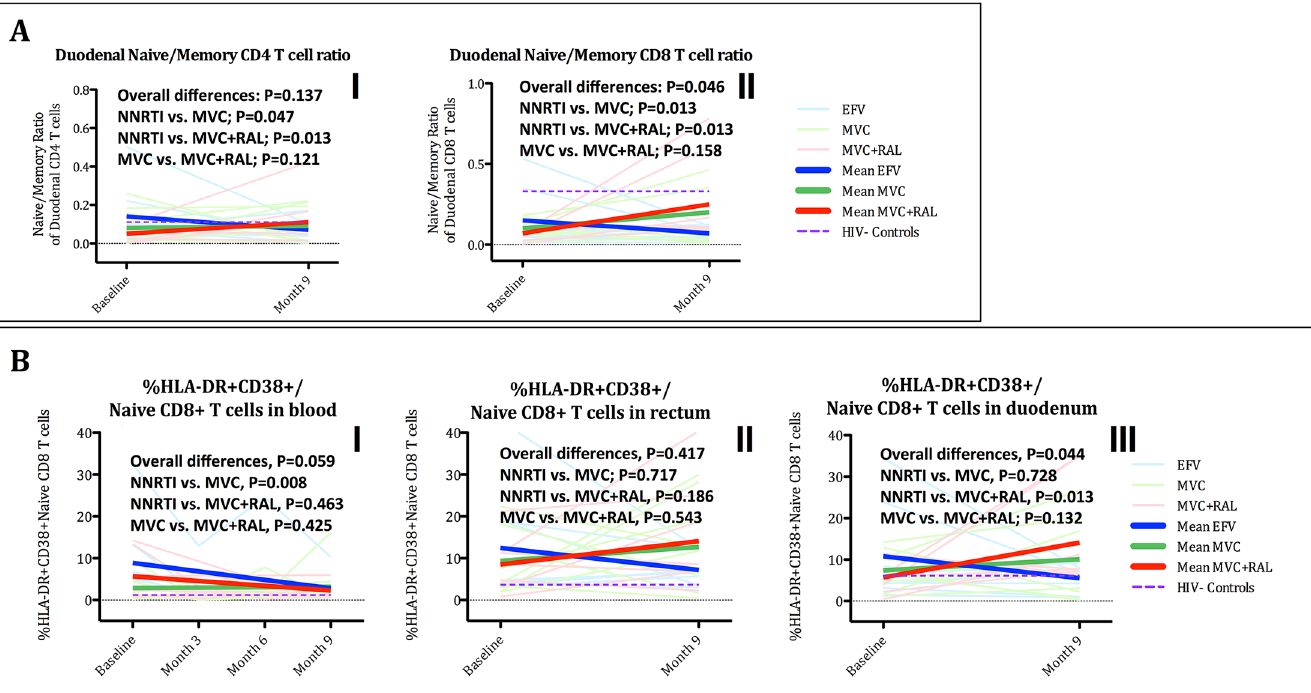
Fig 3. Changes in the naive/memory ratio and CD38 + HLA-DR + naive CD8 T-cells in duodenum. Panel A. Changes in the na ï ve/memory ratio in duodenum for CD4 + (I).and CD8 + T-cells (II). Panel B. Changes in %HLA-DR + CD38 + / naive CD8 T-cells in blood (I), rectum (II) and duodenum (III). The purple dash line represents cross-sectional mean values in controls. The equality of all mean changes among the three groups was tested using a Wald test for the interaction term and is referred as “ Overall differences ” . A statistically significant interaction term (group * month) identified significantly different slopes between treatment